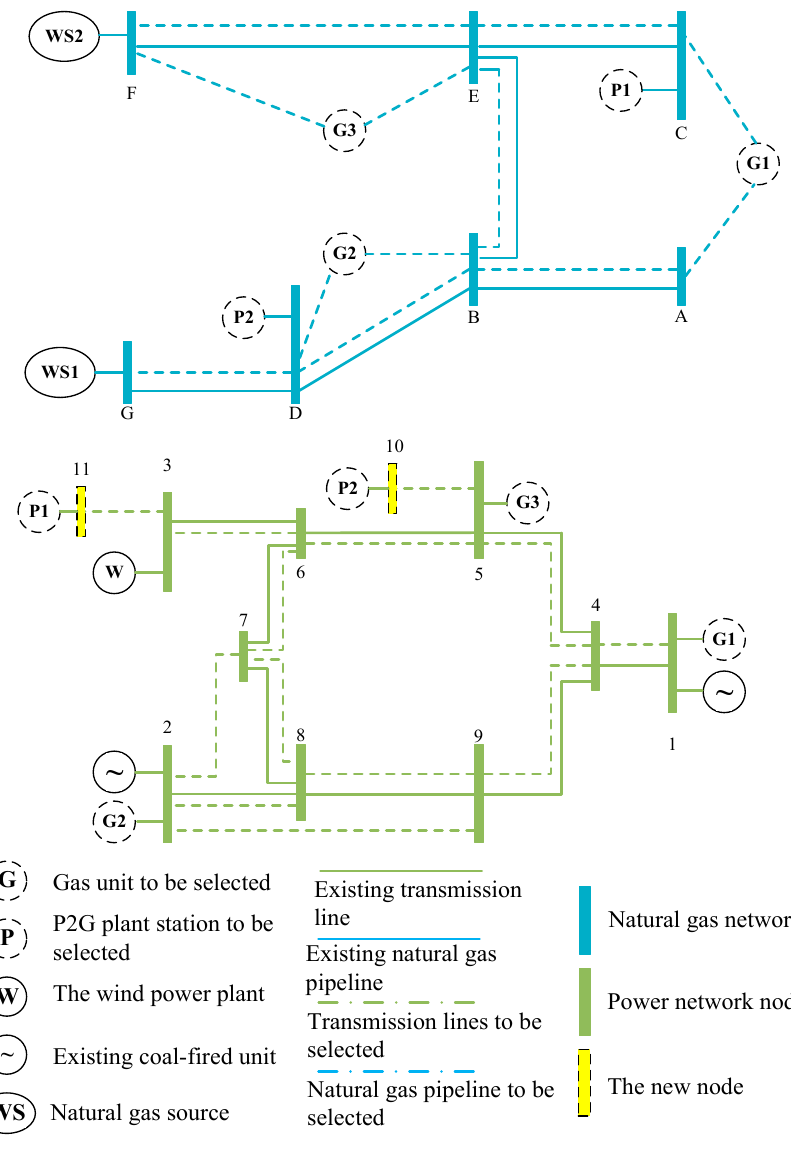
Figure 2. Example structure.